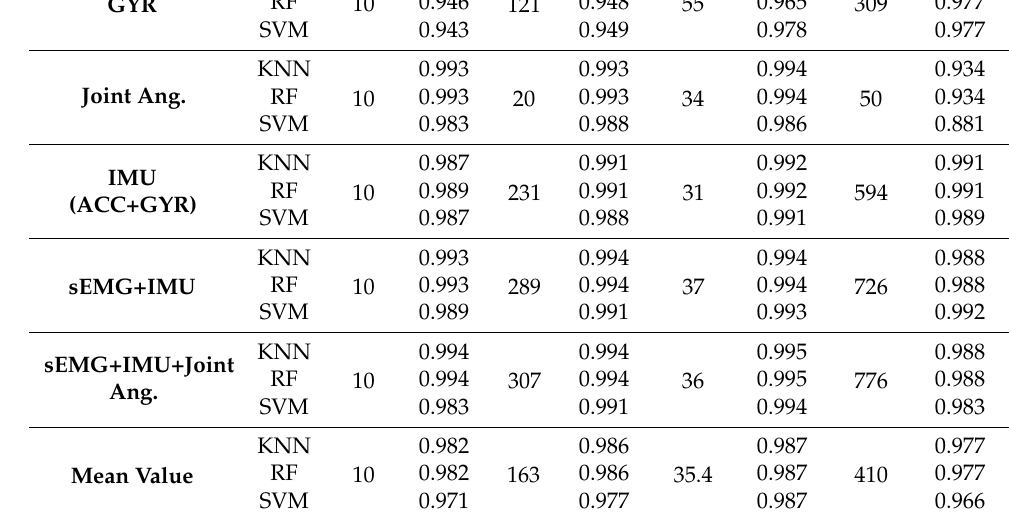
Figure 9. Mean F-Measure of all feature subsets per sensor combination and classification algo- rithms (KNN, RF and SVM).